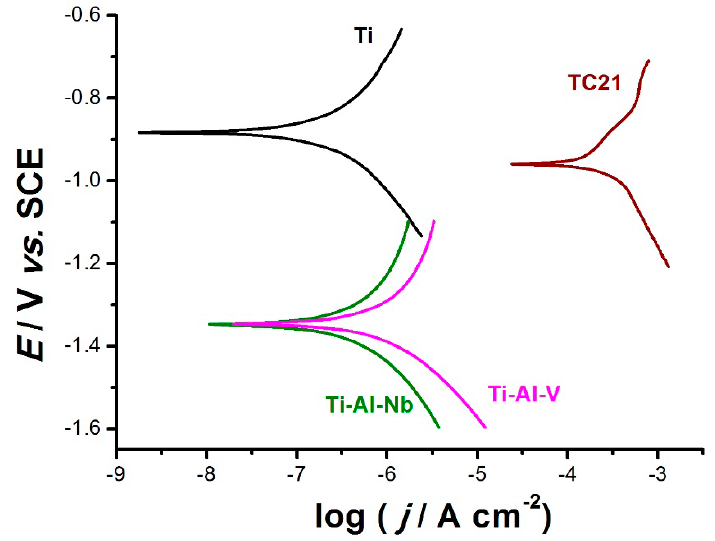
Figure 5. Cathodic and anodic polarization curves recorded for the three tested alloys in comparison with pure Ti, after seven days of exposure in 0.9% NaCl solution at a scan rate of 0.5 mV s -1 at 37 °C.